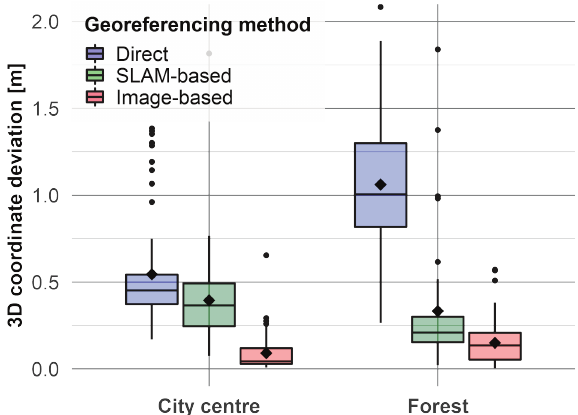
Figure 6. Boxplot with 3D coordinate deviations to the ground truth that represent the absolute accuracy. All samples are listed from left to right by test area (“City centre” and “Forest”) and georeferencing method (“Direct” (blue), “SLAM-based” (green) and “Image-based” (red)). The black diamond symbol indicates the mean 3D coordinate deviation. Figure 5. Boxplot with the precision of the 3D coordinate observations for the test sites “City centre” (left) and “Forest” (right). The blue boxplot on the left represents direct georeferencing, the green boxplot in the middle SLAM-based georeferencing, and the red boxplot on the right image-based georeferencing. The black diamond symbol indicates the mean precision.